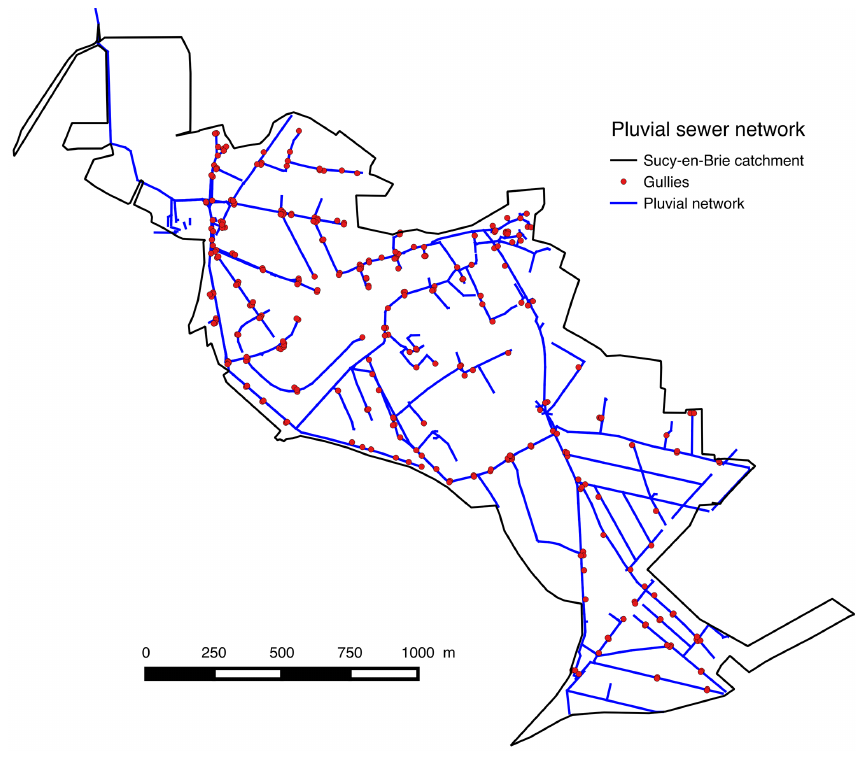
Figure 5. The storm water system of Sucy-en-Brie catchment which is used to implement the Multi-Hydro model. Table 1. Main characteristics of the eight rainfall events selected to perform the scale dependence investigations. Imax is the maximum rainfall intensity recorded in mmh − 1 over